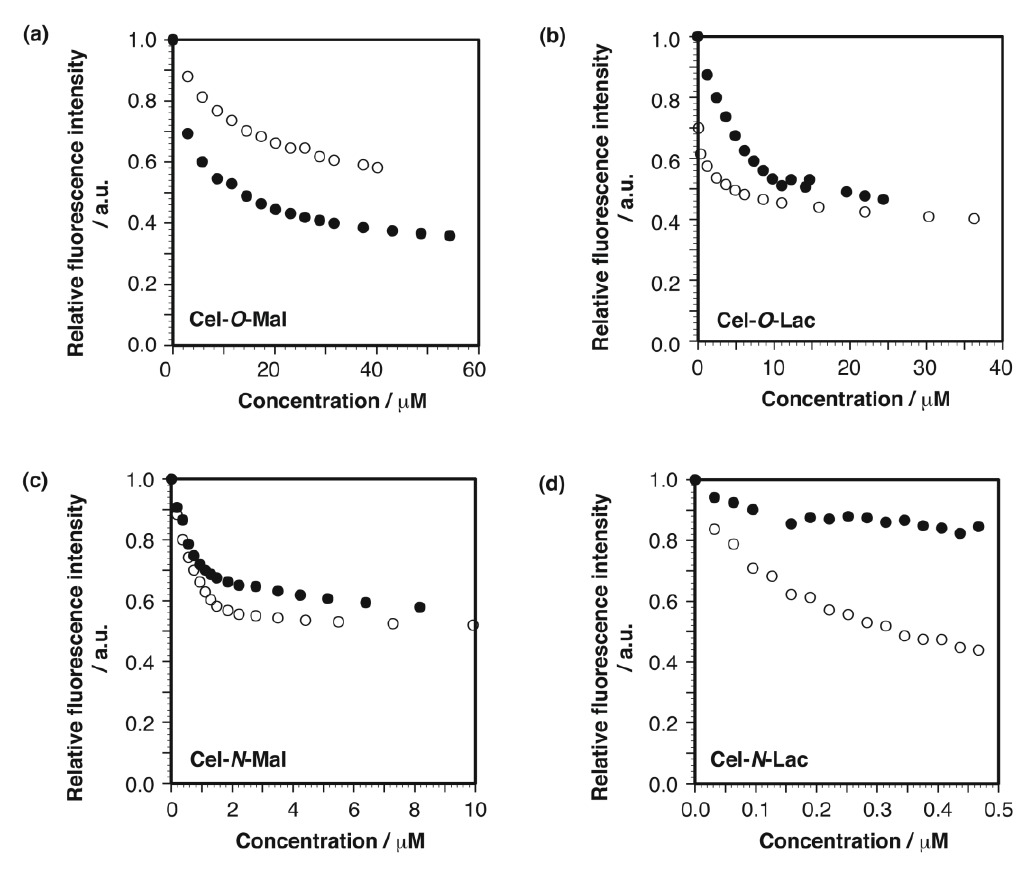
Figure 7. Relative fluorescence intensities ( I / I ) of (closed circle) FITC-ConA and (open 0 circle) FITC-RCA under various concentrations of ( a ) Cel- O -Mal, ( b ) Cel- O -Lac, 120 ( c ) Cel- N -Mal, and ( d ) Cel- N -Lac: Tris-buffer (20 mM, pH 7.2), 20 °C, Ex = 490 nm, Em = 518 nm, d = 10 mm, [CaCl ] and [MnCl ] = 100  2 2